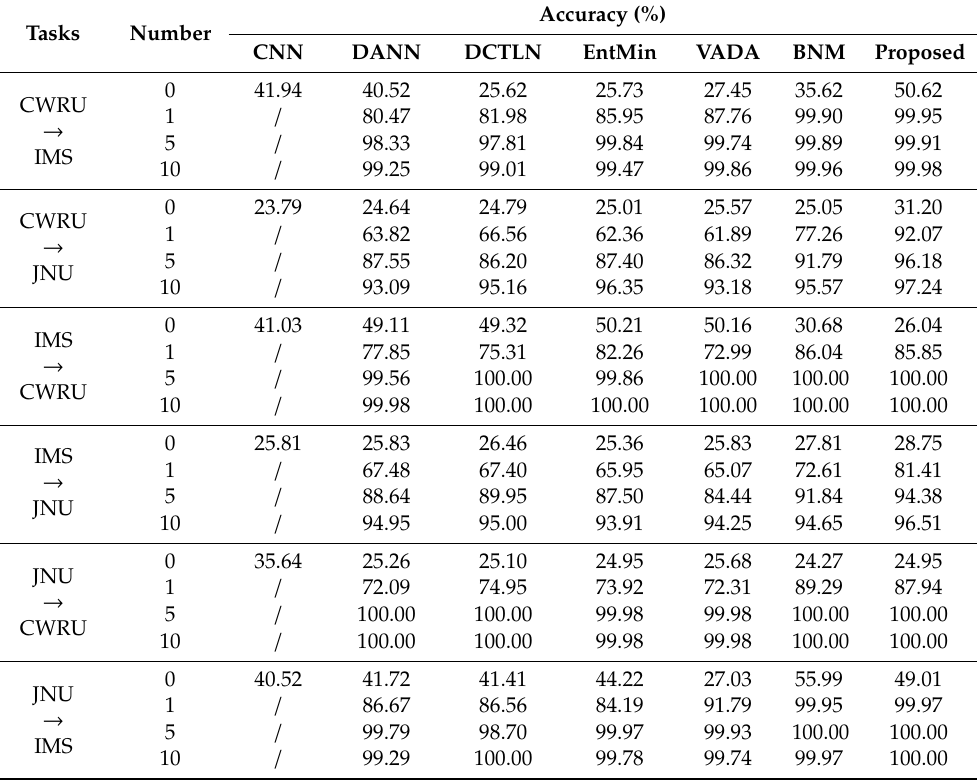
Table 4. Results of diagnosis accuracy under di ff erent number of labeled target